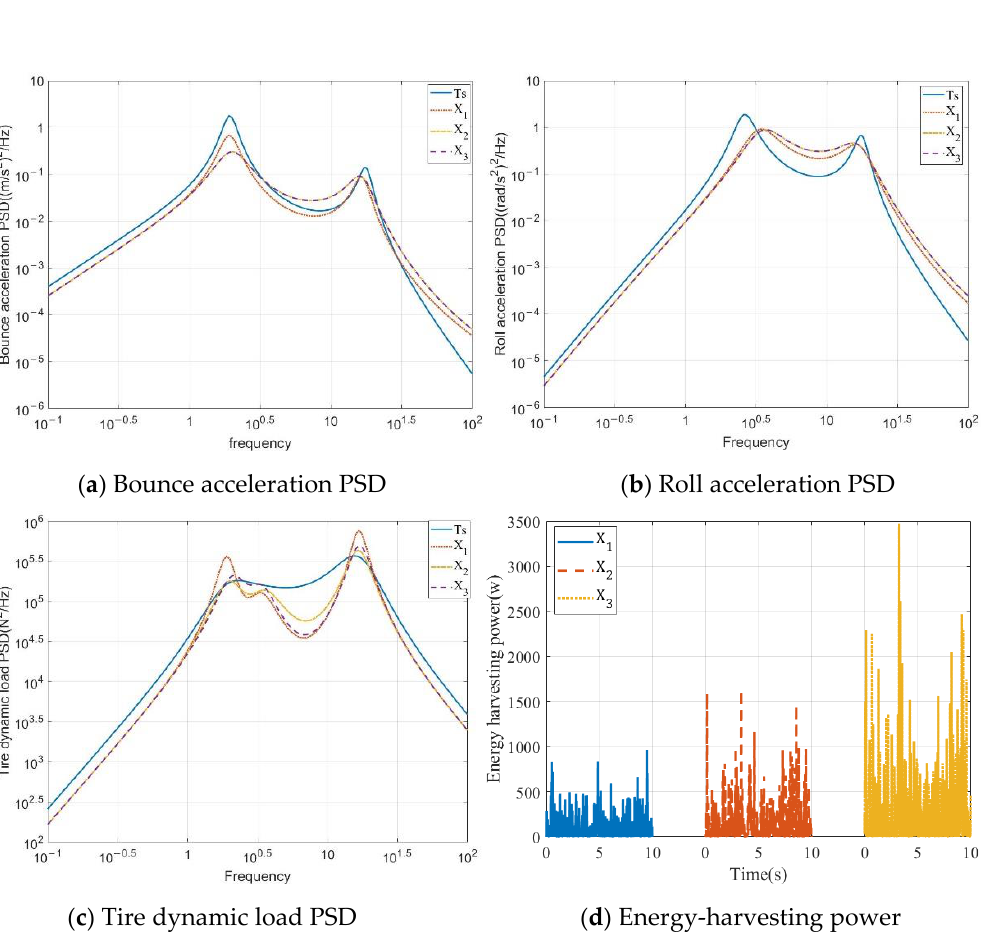
Figure 11. Acceleration and tire dynamic load PSD and energy-harvesting power. (a) Bounce ac- celeration PSD; (b) Roll acceleration PSD; (c) Tire dynamic load PSD; (d) Energy-harvesting